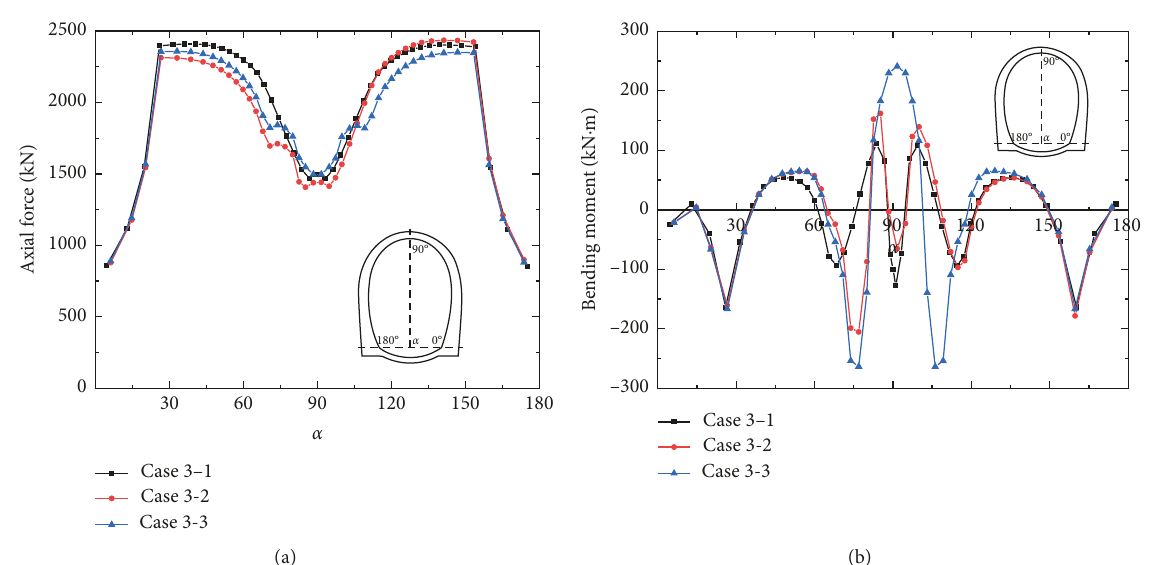
Figure 6: Internal forces of concrete lining in group 3. (a) Axial forces. (b) Bending